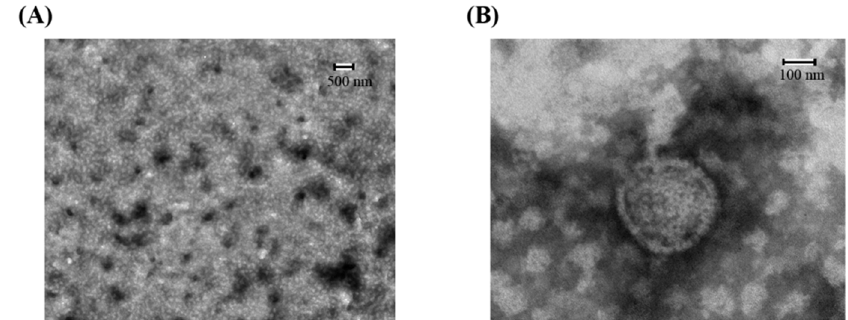
Figure 1. Transmission electron microscopy (TEM) micrograph of nanoparticles at 500 nm ( A ) and 100 nm ( B ). The samples were immobilized on copper grids and dried at room temperature. Then they were stained with phosphate tungsten acid and examined by TEM.